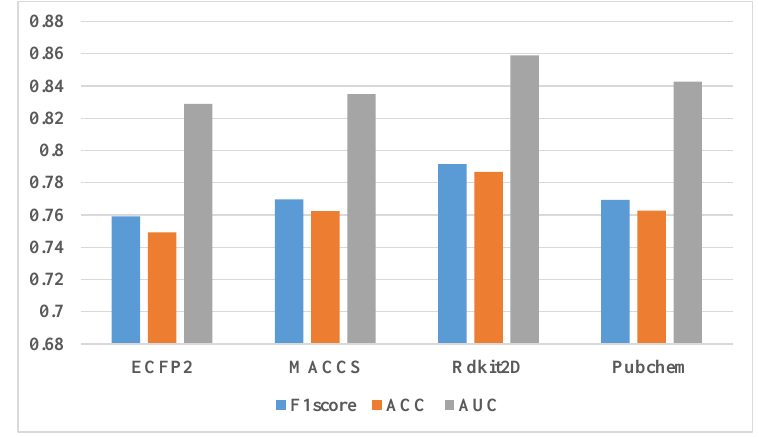
Figure 8. Results of ablation experiments by using only one fingerprint.